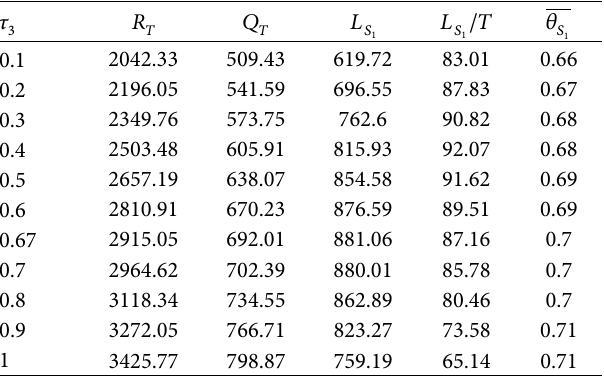
Table 5: Product sales and average freshness under optimized fixed FKE.